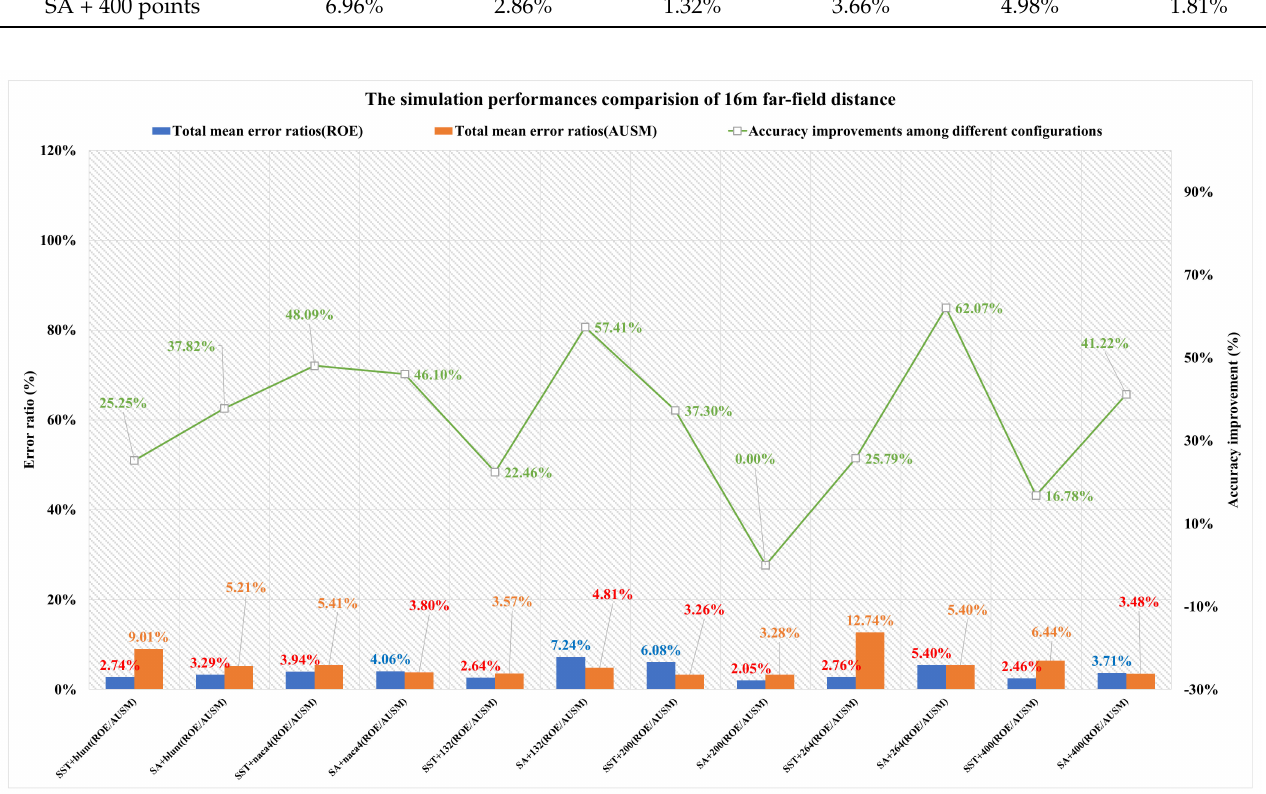
Figure 26. Comparison of the simulation performances of 16 m far-field distance under different simulation